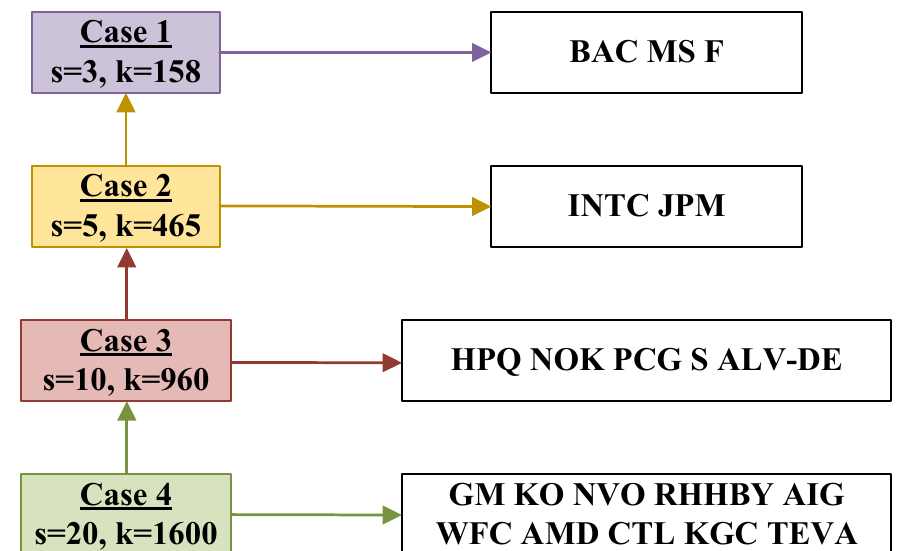
Figure 1. The portfolio cases’ stocks that have been utilized in the TMCPI problem